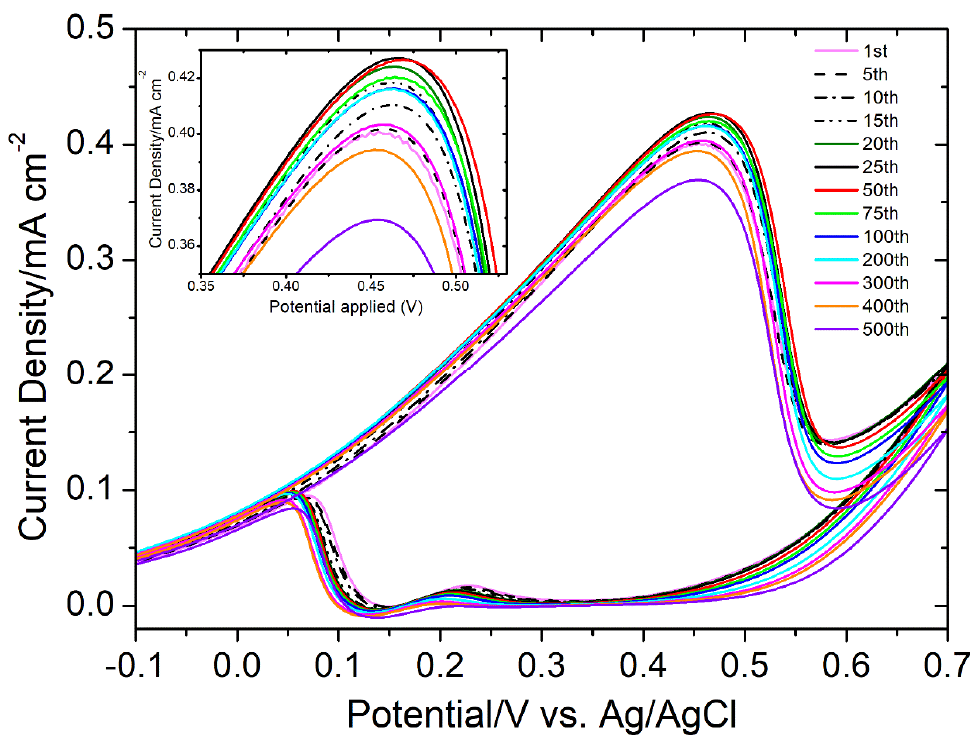
Figure 6. CV curves of NPG_16h for 500 scan cycles in a solution of 5 M CH 3 OH in 0.5 M KOH at a scan rate of 20 mV/s. The inset gives a magnified look at the potential range, peak potential, and peak current density of methanol electro-oxidation.